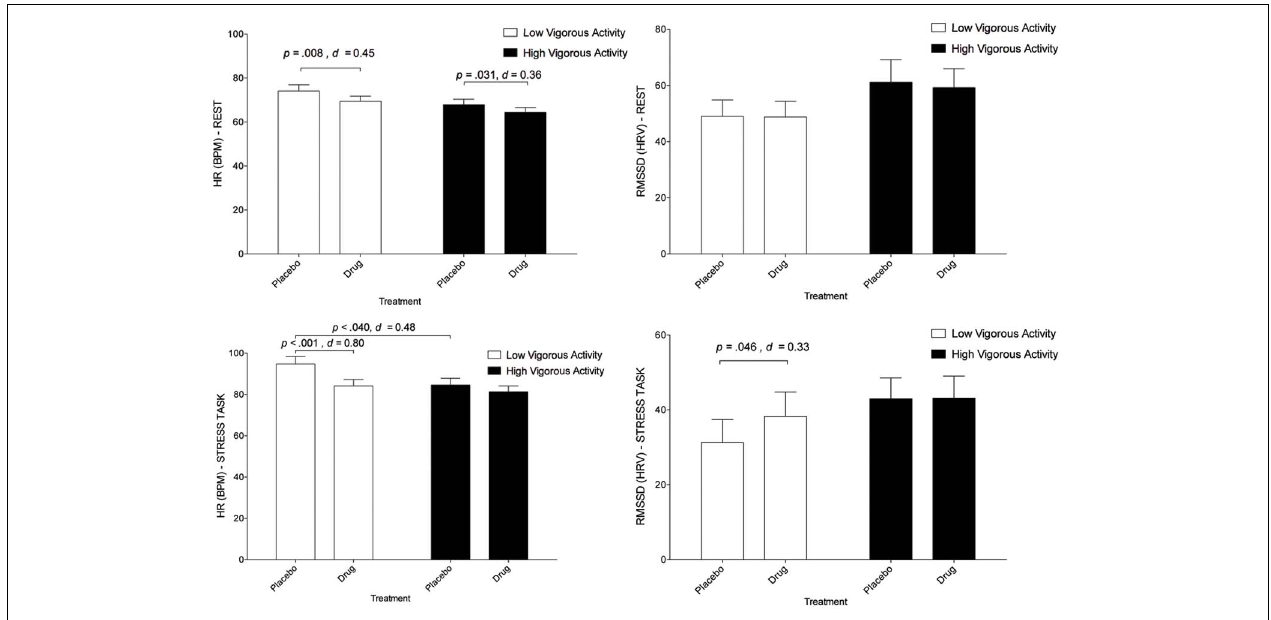
FIGURE 2 | The interaction between treatment and physical activity category on cardiovascular responses (with standard error bars). Top left graph: Effects on HR at rest. Top right